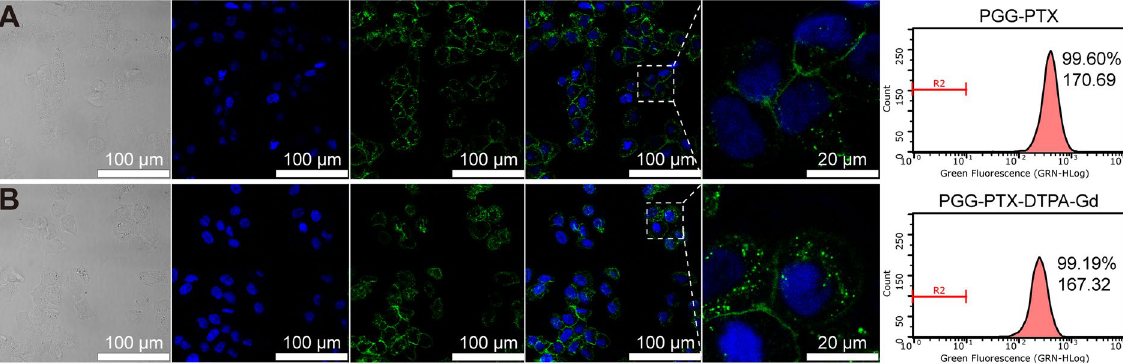
Figure 3. The CLSM images of cellular uptake and flow cytometry for PGG-PTX/DiO NPs ( A ) and PGG-PTX- DTPA-Gd/DiO NPs ( B ). The numbers in flow cytometry pictures represent percentages of DiO-positive cells and mean of fluorescence intensity, respectively. The cellular uptake of PGG-PTX-DTPA-Gd/DiO NPs by NCI- H460 cells was not significantly changed with PGG-PTX/DiO